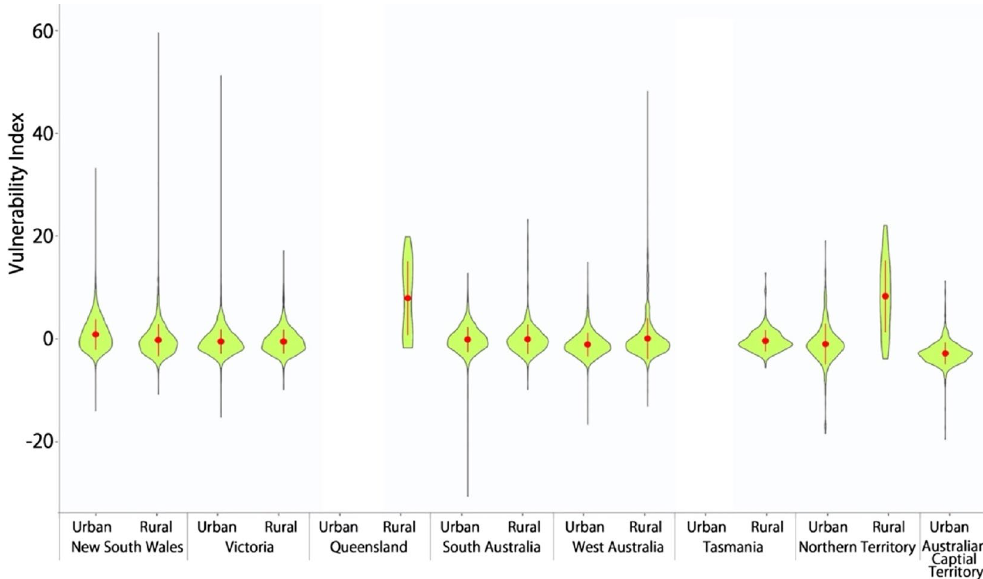
Figure 8. Violin plots showing the statistical distribution of the vulnerability index in earthquake-affected areas. Statistical details are provided in Supplementary Table S11. The vertical black line indicates the range (maximum and minimum) of the vulnerability index. The width of water-drop pink areas indicates the density distribution of the vulnerability index; a wider width means more spatial units (SA1s) concentrate in that vulnerability index. The red dot indicates the mean of the vulnerability index and the vertical red line represents 95% confidence intervals. X axis presents the ACT as urban space together with seven states which were divided into urban and rural space. In New South Wales and West Australia, the range of the vulnerability index in earthquake-affected rural areas is much wider than that in urban areas, while oppositely in Victoria, South Australia and Northern Territory. In particular, the vulnerability index in earthquake-affected areas ranges low in Adelaide (− 30.417 to 12.997) compared to other capital cities and rural areas (lowest to − 19.224 in ACT and highest to 59.575 in rural areas of New South Wales). Violin plots showing the statistical distribution of the vulnerability index in flood- and wildfire-affected areas (similar to Fig. 8) are displayed in Supplementary Figs. S10 and S11 with descriptions provided in Supplementary Note